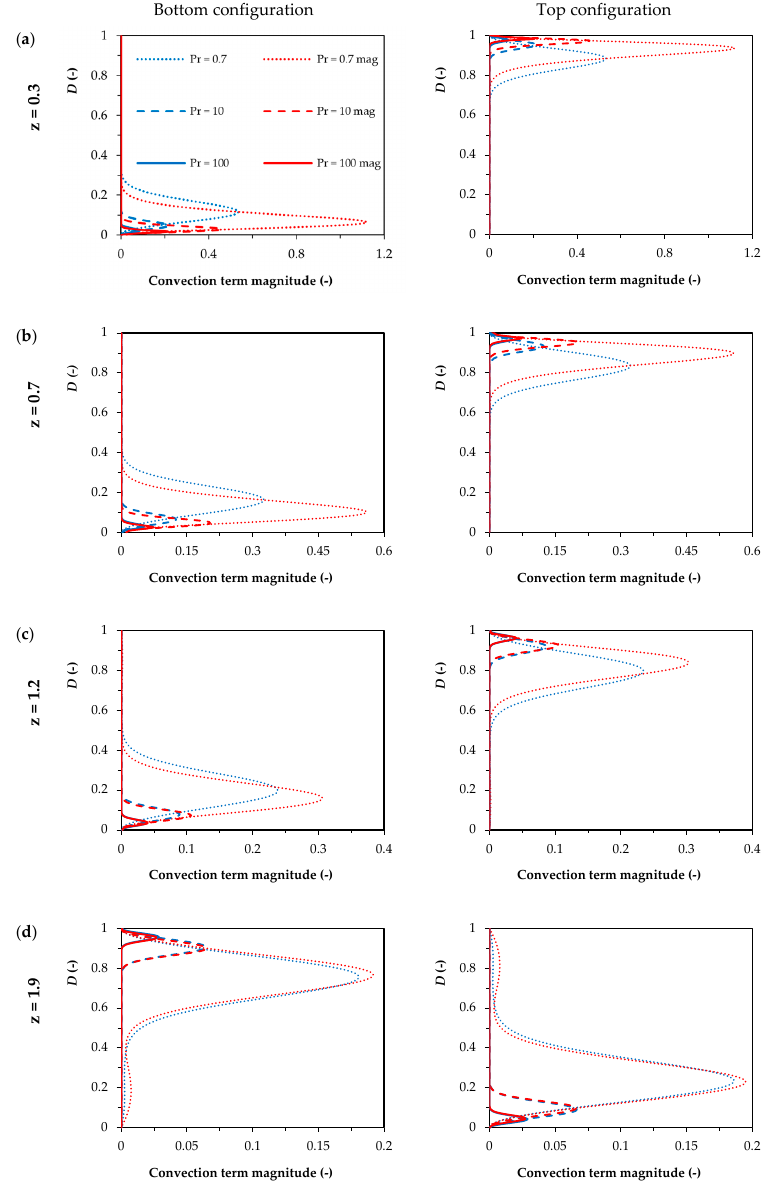
Figure 12. Energy budget calculated for the radial cross-sections located at: ( a ) z = 0.3, ( b ) z = 0.7, ( c ) z = 1.2, ( d ) z = 1.9.